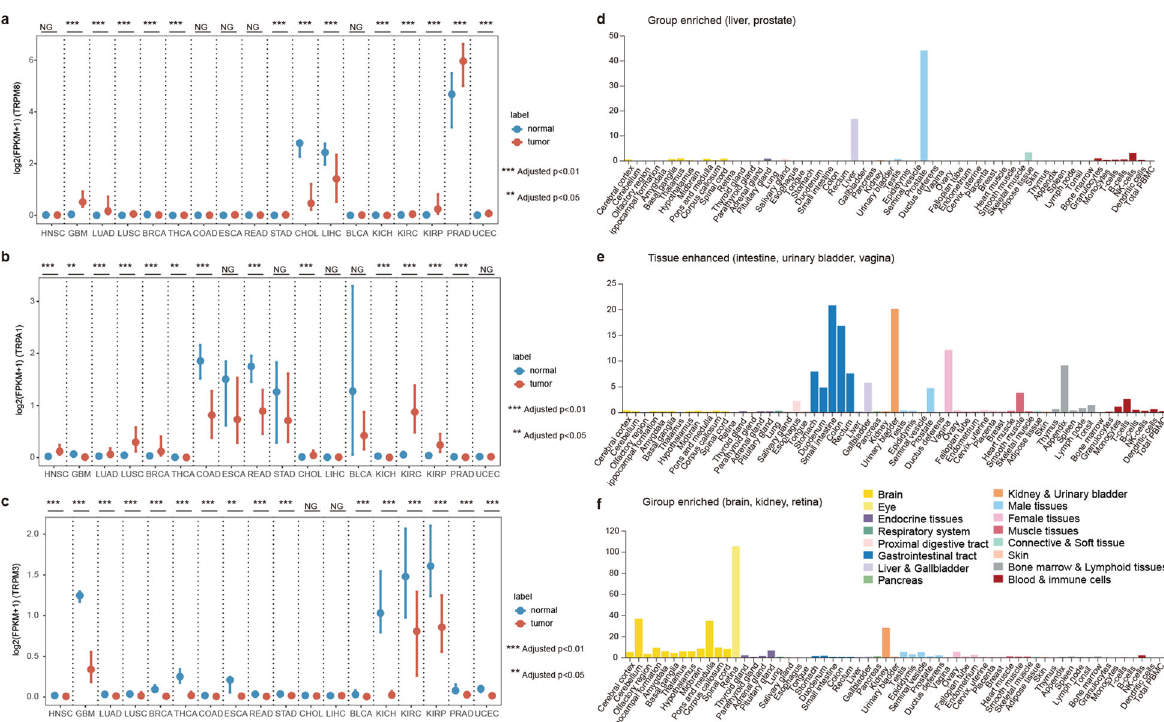
Fig. 3 Expression of TRP genes across tissues and cancer types. a Expression of TRPM8 across cancers. b Expression of TRPA1 across cancers. c Expression of TPRM3 across cancers. d Expression of TRPM8 across normal tissues. e Expression of TRPA1 across normal tissues. f Expression of TRPM3 across normal tissues. Data of normal tissues were downloaded from human protein atlas. Tissues were colored by the organs. Centre line of boxplot is the median, and bounds of box are the upper and lower quartile. ***adjusted p < 0.01, **adjusted p < 0.05.